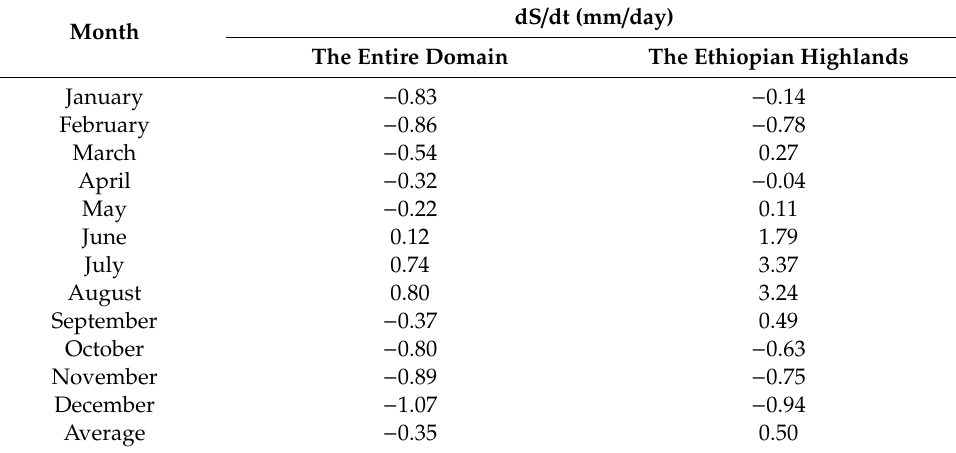
Figure 10. Time series for the average precipitation, the runoff, the evapotranspiration, and the change in terrestrial water storage for the study period over the entire ENB domain ( a ) and over the Ethiopian Highlands ( b ). Table 2. Average change in terrestrial water storage for each month.